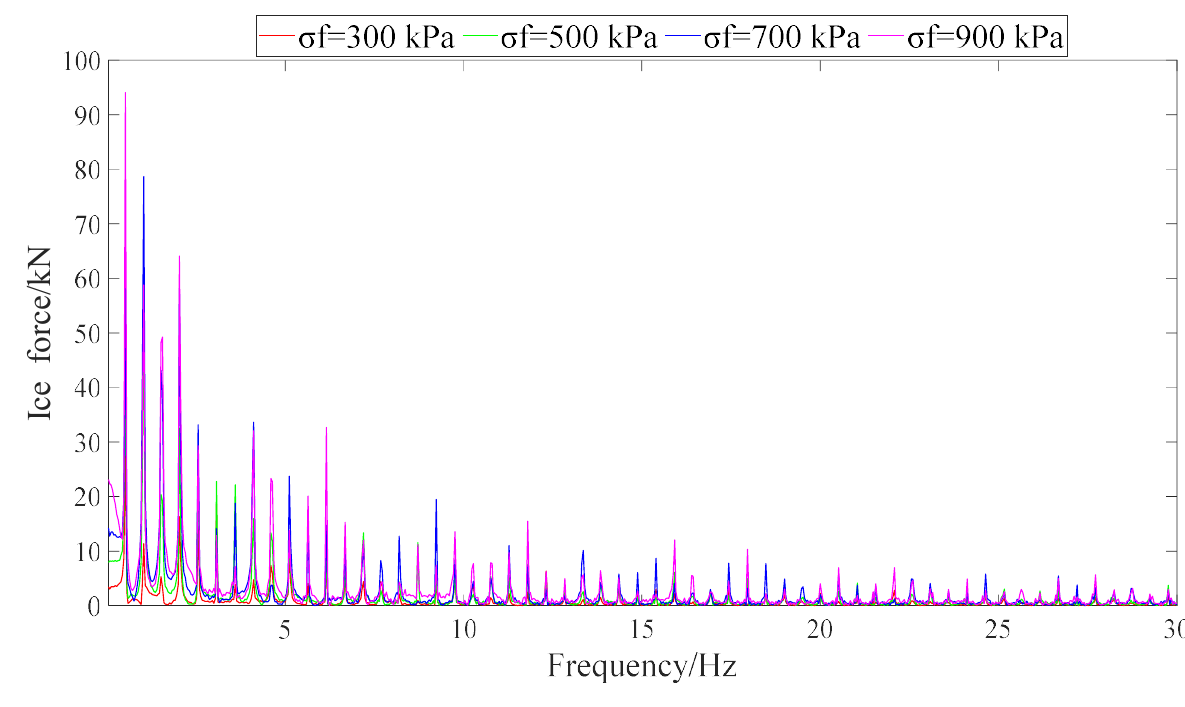
Figure 20. Frequency domain curves with different bending strength ( σ f ).